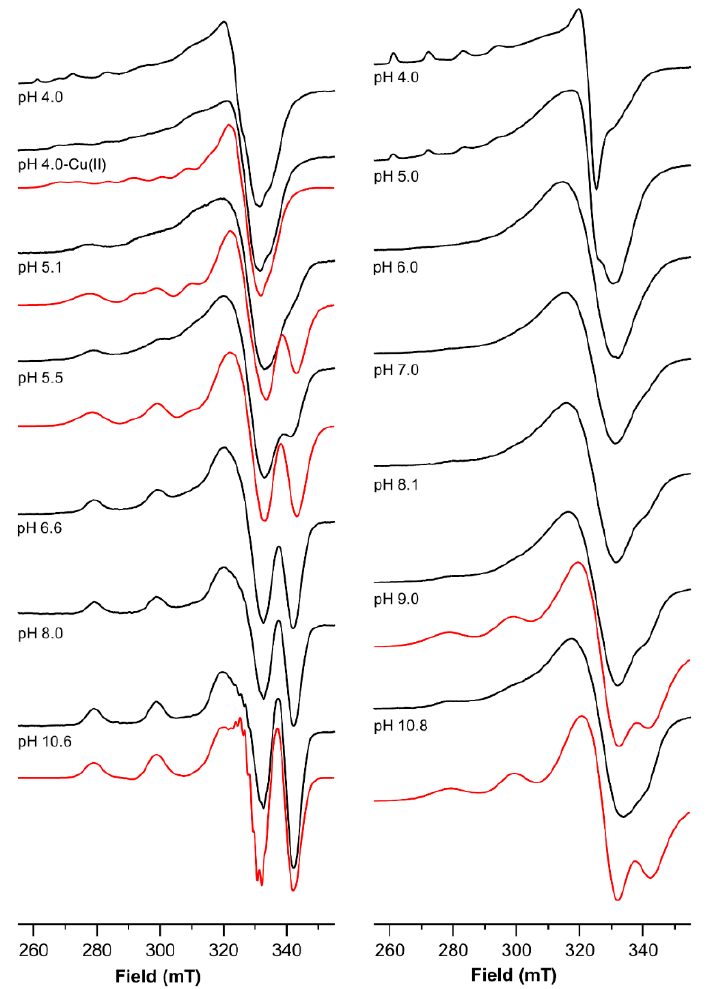
Figure 6. ESR spectra (150 K) of the complex species of Ctr1 (1-14) , with Cu 2+ as function of the pH and the ligand-to-metal ratio (left panel, L:Cu = 1:1; right panel, L:Cu = 1:2). Computed spectra are shown in red.